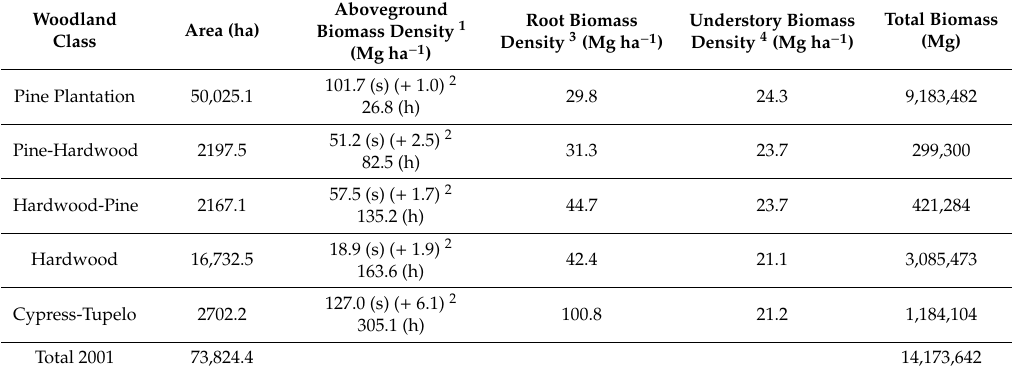
Table 4. Forest vegetation biomass density and total biomass estimates for softwoods (s) and hardwoods (h) for 2001 using the national biomass estimator equations [34], forest land area (Table 1) and forest understory values